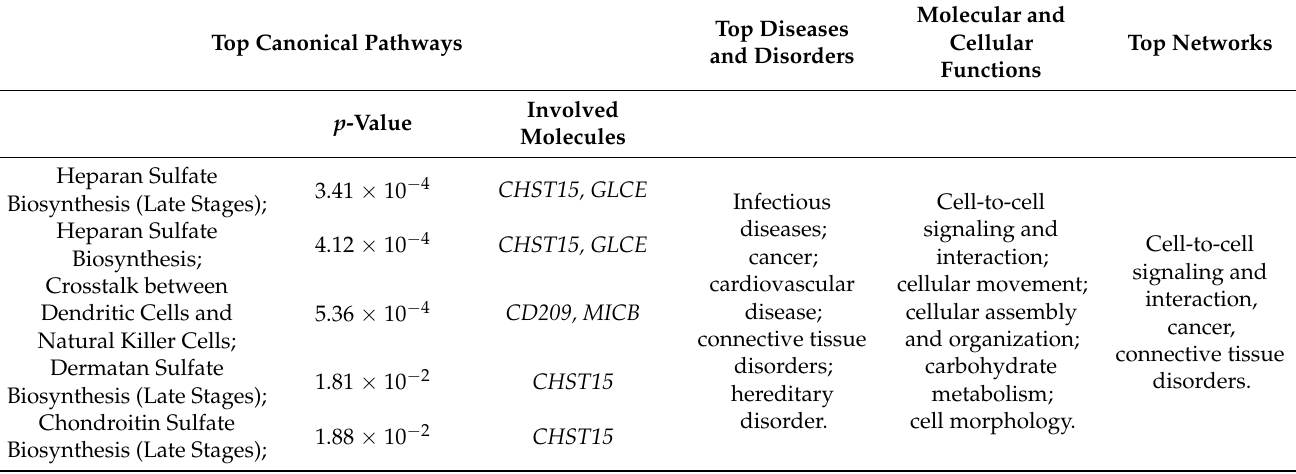
those of heparan sulfate biosynthesis at both late ( p -value = 3.41 × 10 − 4 ) and early stages ( p -value = 4.12 × 10 − 4 ) as well as crosstalk between dendritic cells and natural killer cells ( p -value = 5.36 × 10 − 4 ) (Table 3). Table 3. Canonical pathways, diseases, bio functions, and networks associated with the genes encoding identified endome- trial cancer risk-associated proteins a